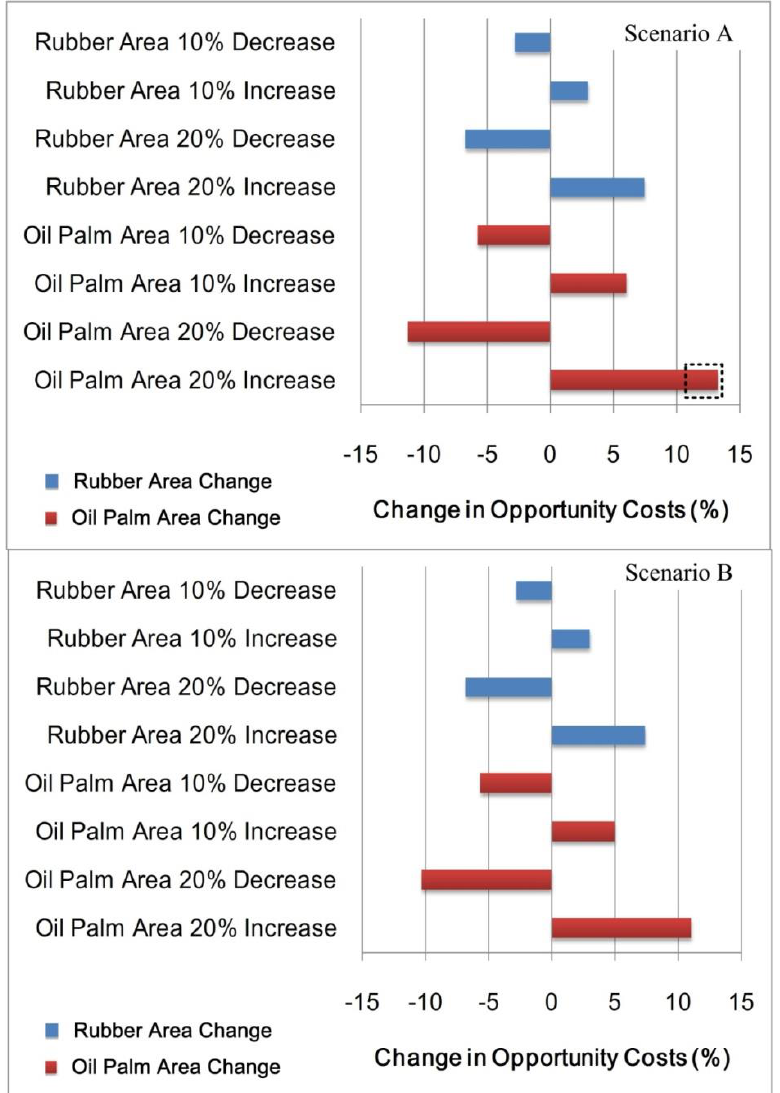
Figure 6. Sensitivity analysis of plantation area to OC under two scenarios: (1) Scenario A: without consideration of carbon sequestration in plantations, and (2) Scenario B: with consideration of carbon sequestration in plantations.